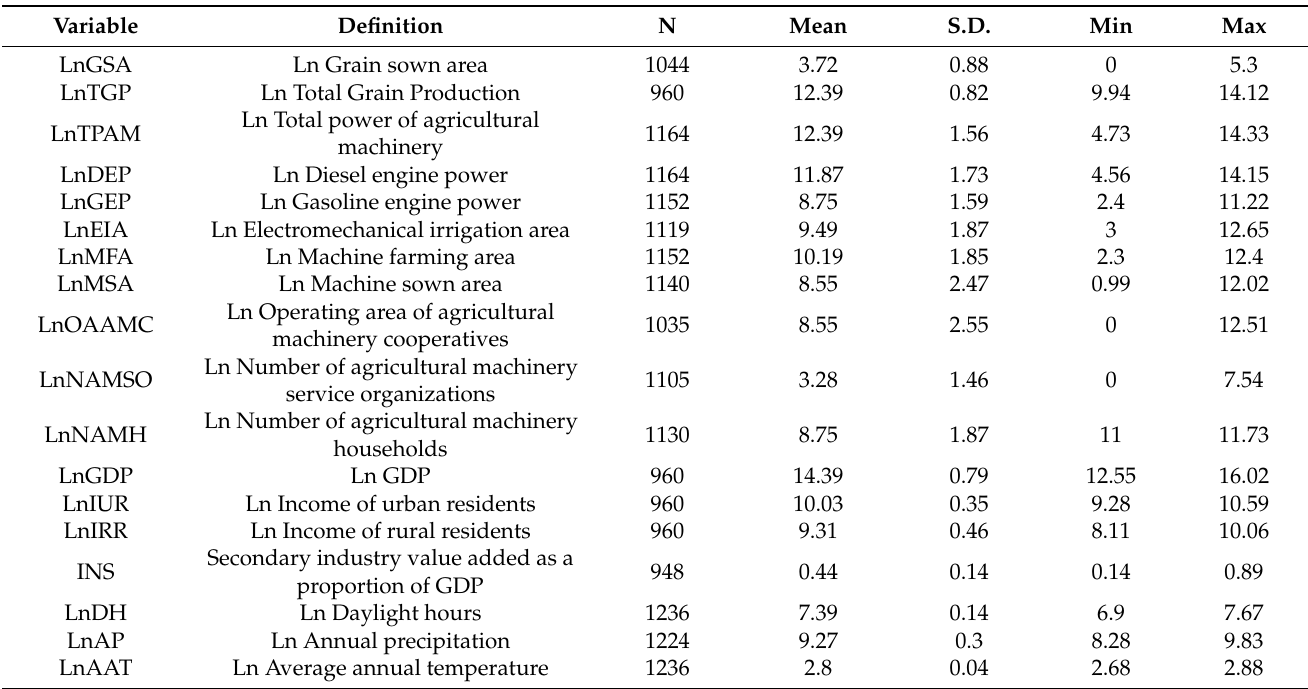
Table 1. Summary